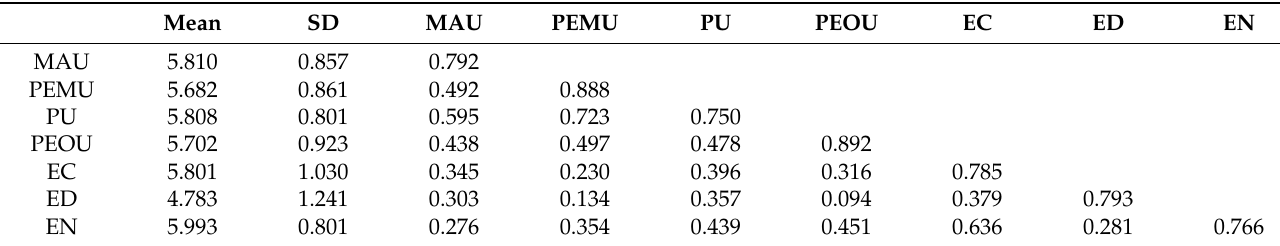
Table 3. Discriminant Validity Test Results.